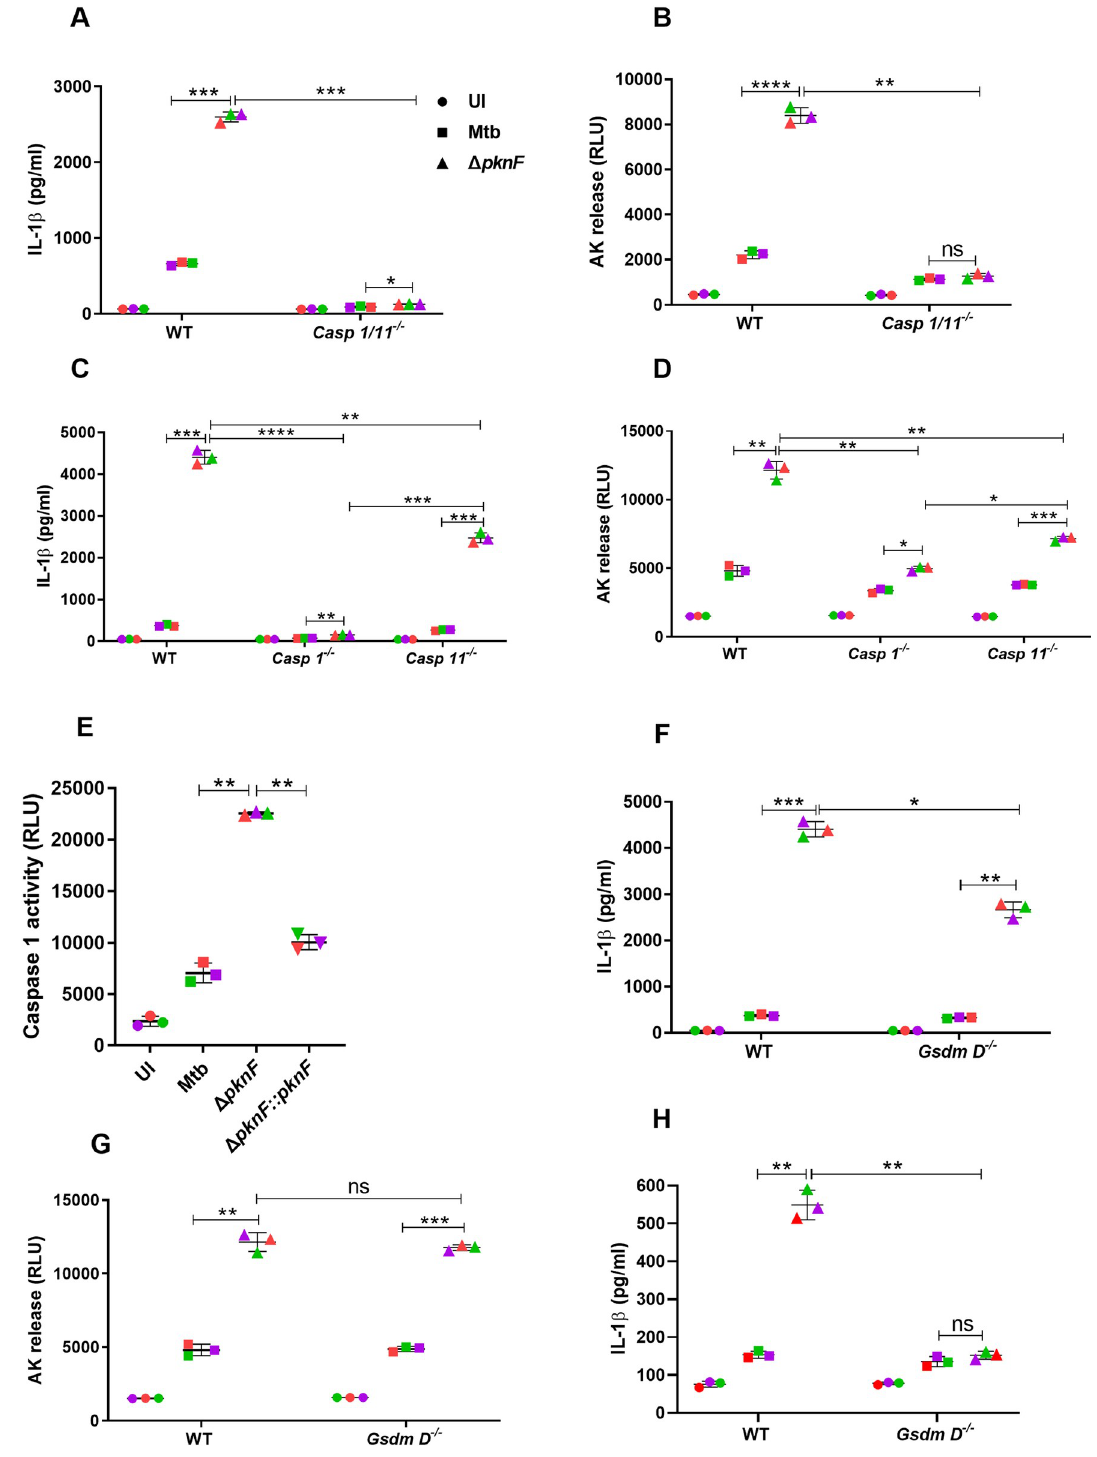
Fig 4. The impact of Casp1, Casp11 and GSDMD on the increased production of IL-1 β and cell death by the pknF Mtb mutant. BMDMs derived from wild type (WT), Casp1 -/- , Casp11 -/- , Casp1 -/- /11 -/- and GSDMD -/- mice were either left uninfected (UI, solid circles) or infected with CDC1551 Mtb wild-type (solid squares) and Δ pknF mutant (solid upright triangles) at an MOI of 10 for 4h. The cell free supernatants were assessed for IL-1 β secretion by ELISA at 20 hpi (A, C, F) and at 6 hpi (H) and (B, D, G) cell death by measuring the release of adenylate kinase (AK). WT BMDMs were either left uninfected (UI, solid circles) or infected with different